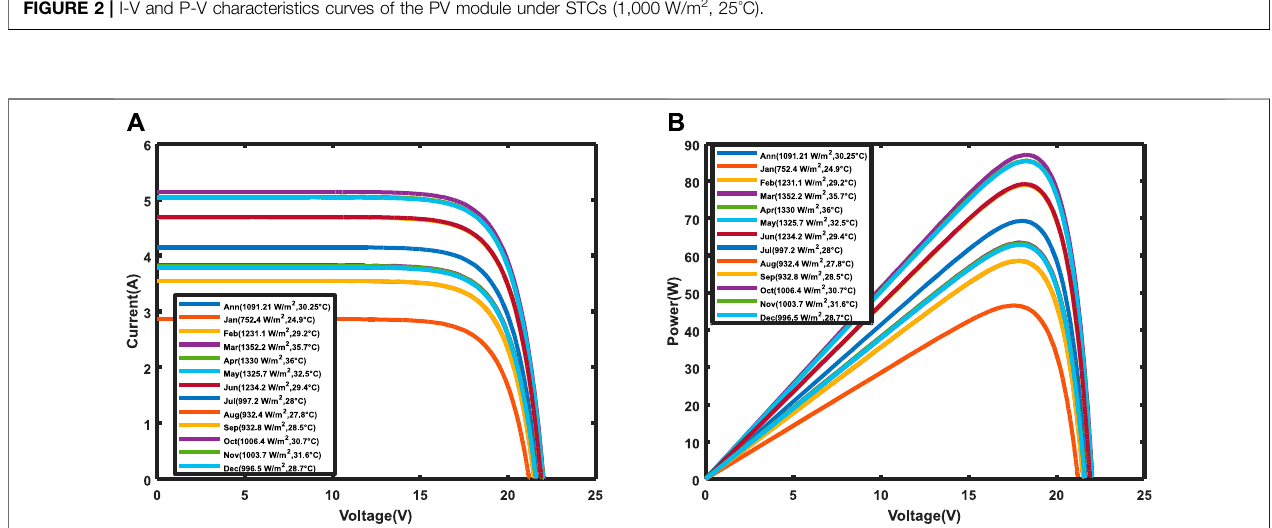
FIGURE 3 | (A) I-V and (B) P-V characteristics curves of the PV module under variation of irradiance and temperature at the study site.